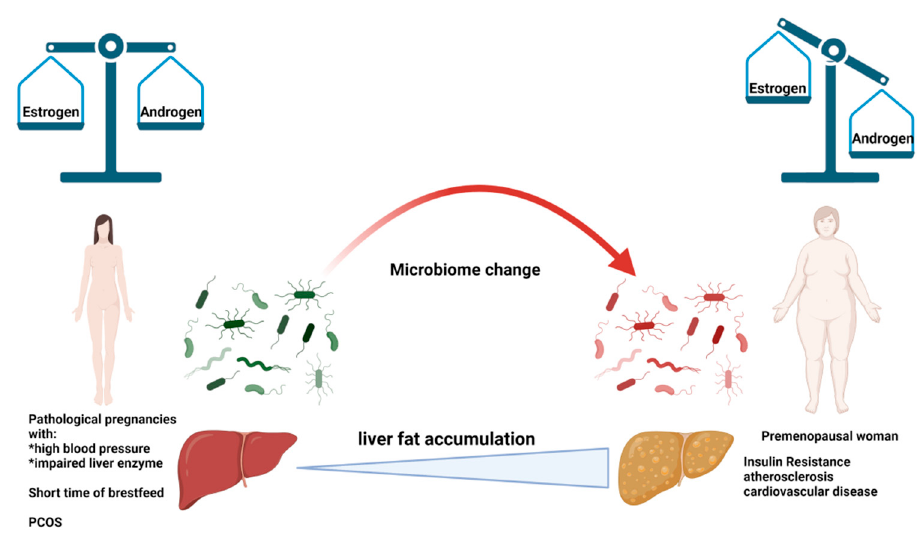
Figure 6. Causes that increase the risk of developing NAFLD at premenopausal age. Imbalance of sex hormones, changes in the intestinal microbiota, pathological pregnancies with increased blood pressure, pregnancies with diabetes, dysregulation of liver enzymes, short duration of breastfeeding and PCOS during the fertile age may increase the risk of being affected by premenopausal NAFLD.